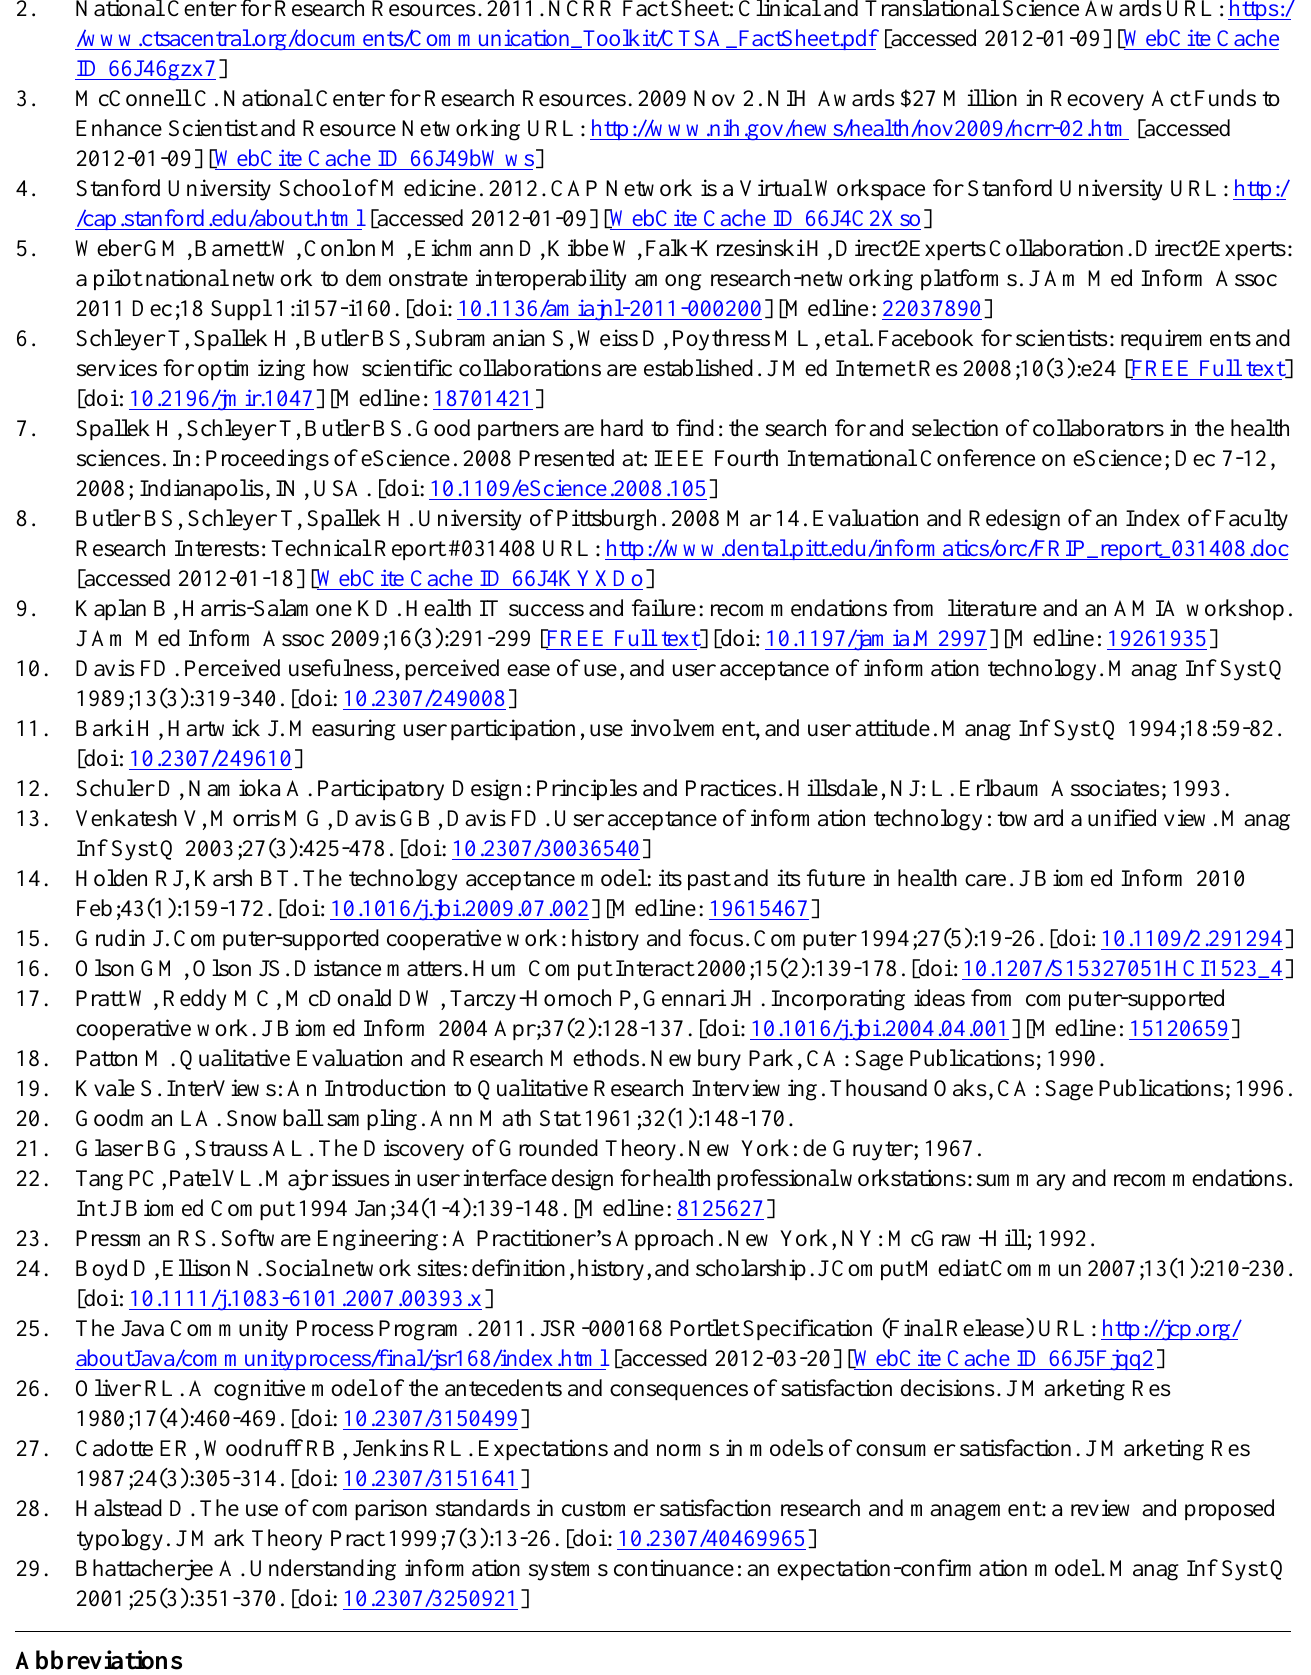
CTSA: Clinical and Translational Science Awards CTS: clinical and translational